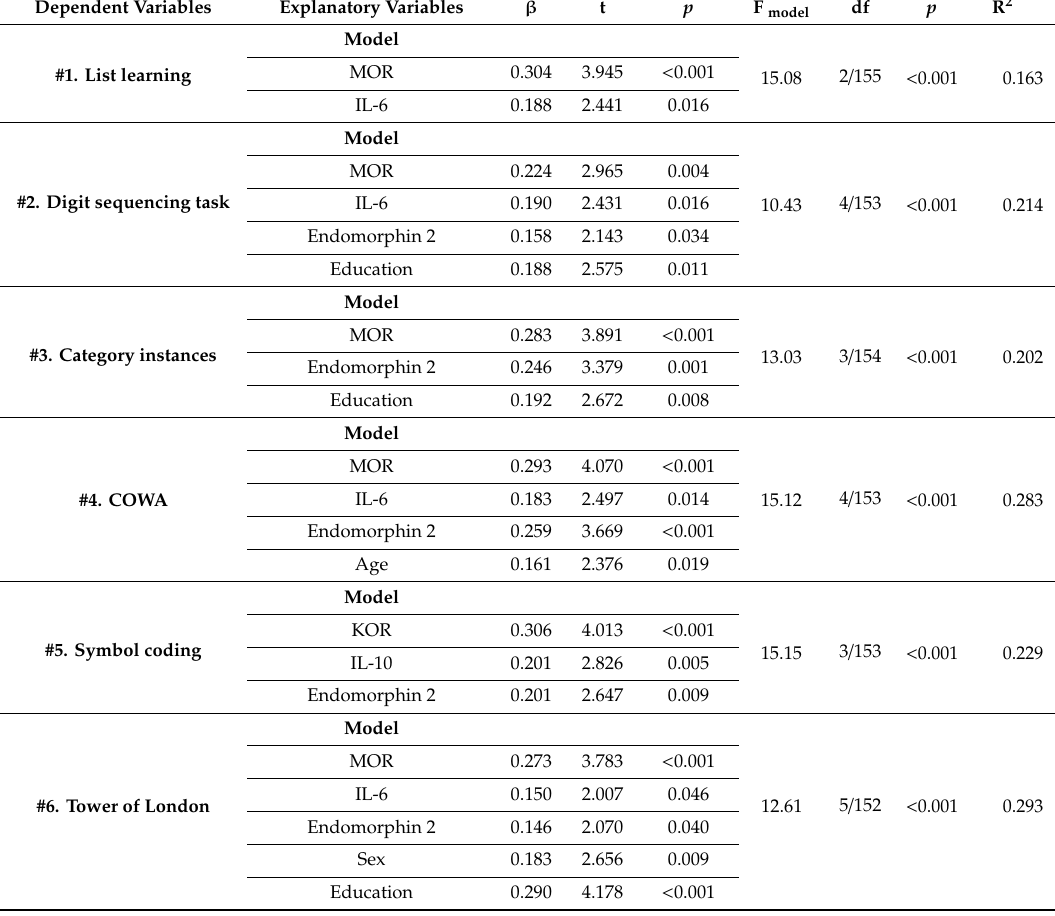
Table 7. Results of multiple regression analysis with neurocognitive test scores as dependent